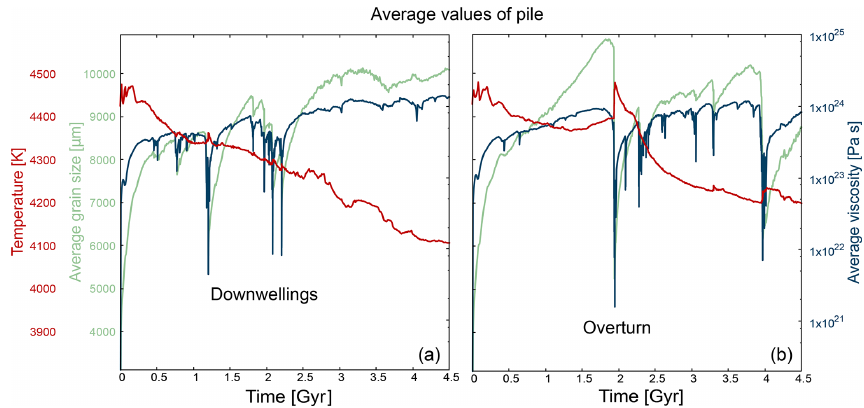
Figure 6. Average values for temperature, grain size and viscosity inside the pile. (a) Simulation no. 3 shows the effect of several strong downwelling events in the early stages of the evolution. (b) Simulation no. 7 displays the effect of two overturn events, intermittent by a mobile-lid phase. All properties are plotted in the same graph to emphasise the correlation between grain size and viscosity development and the anticorrelation of temperature